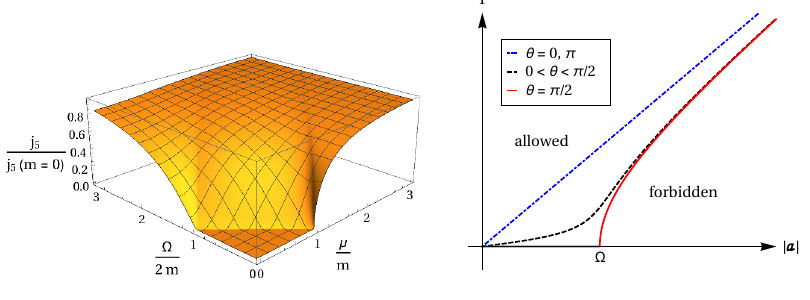
Such suppression of the axial current at low temperatures in the region of Ω < 2( m − | µ | ) may be of interest from the experimental point of